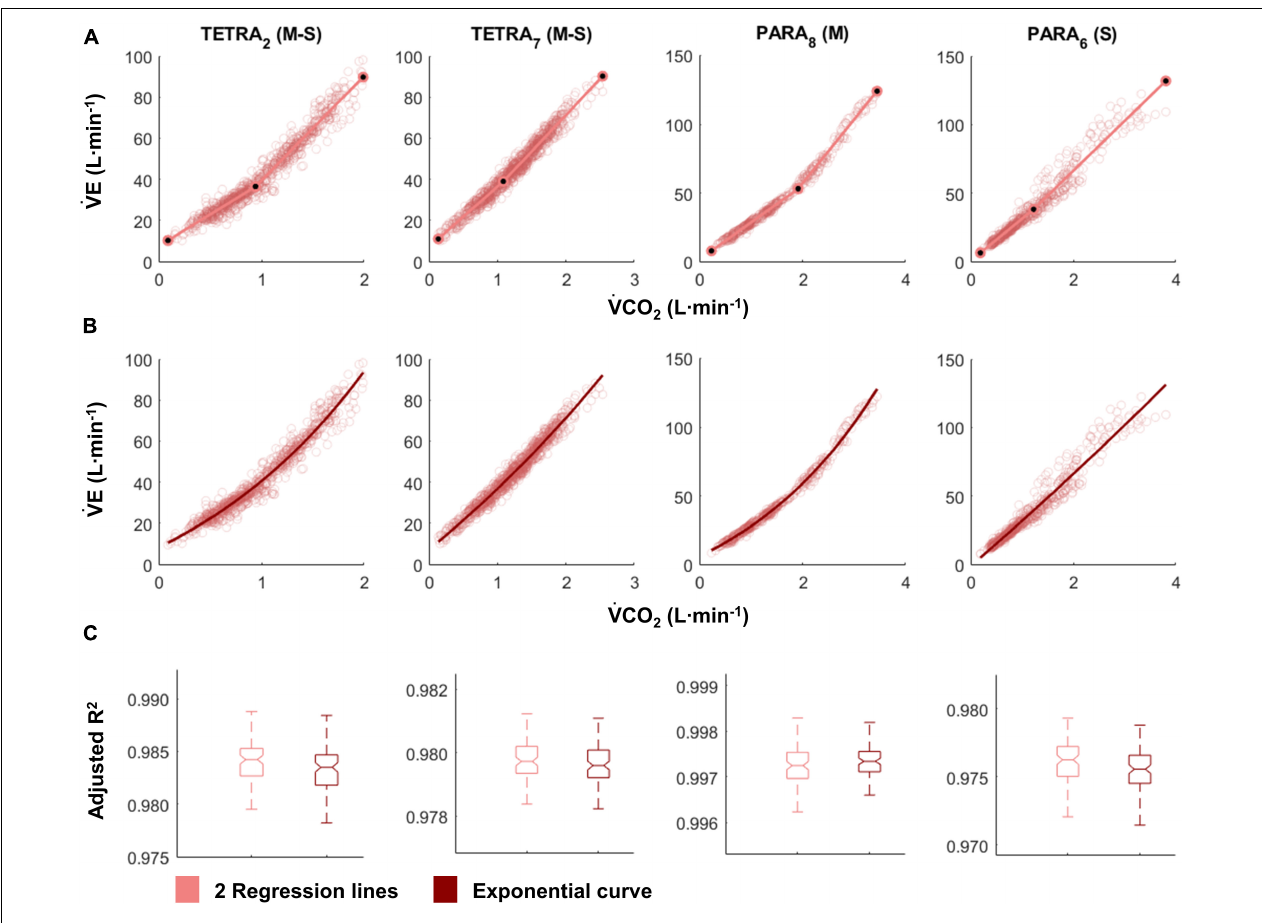
FIGURE 2 | ˙VCO 2 -˙VE plots fitted with the two linear regression lines (breakpoint model, respiratory compensation point method; A ) and an exponential curve (no-breakpoint model; B ) for example athletes with tetraplegia and paraplegia who exhibit the most and least distinct breakpoint within their respective groups (TETRA 2 , TETRA 7 ; PARA 8 , PARA 6 ; participant number in subscript). Notched boxplots are presented to compare the adjusted R 2 values between the breakpoint and the no-breakpoint model for each participant (C) . Figures for all individual participants are provided in Supplementary Figure 3 . ˙VCO 2 , Carbon